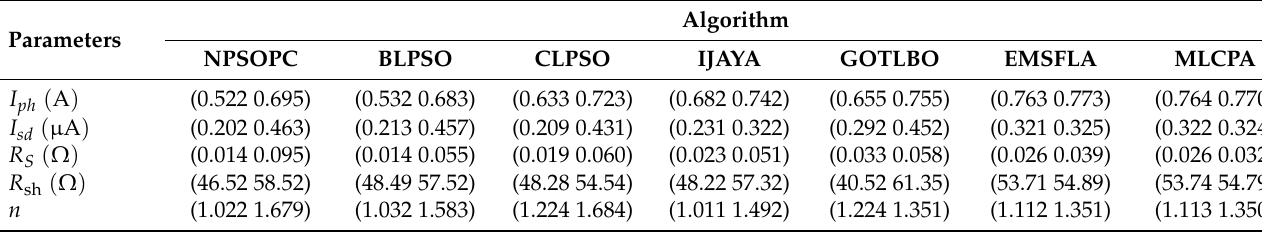
Table 7. Confidence intervals on SDM.